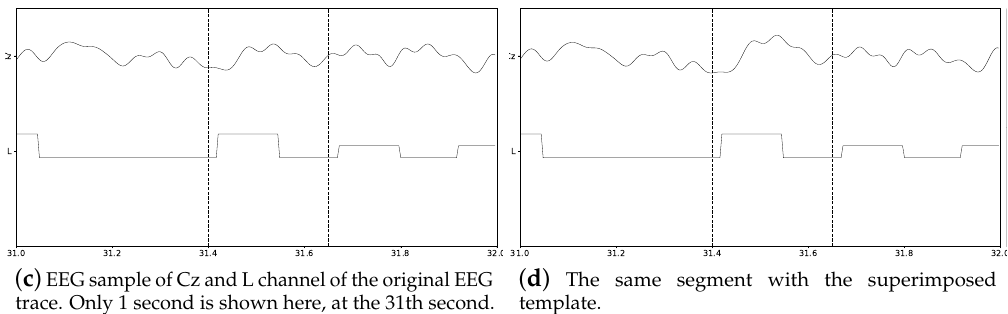
Figure 3. Eight-channel EEG signal for Subject Number 1 of the pseudo-real dataset without and with the superimposed ERP Template. The channel L, the mark which identifies where to superimpose the P300 ERP, is shown as well as the channel S which identifies the stimulus that was presented. On ( c , d ) the small variation that was introduced by the superimposition of the ERP can be seen enclosed by the vertical bars, where the slope of the bump on subfigure ( d ) is slightly bigger.